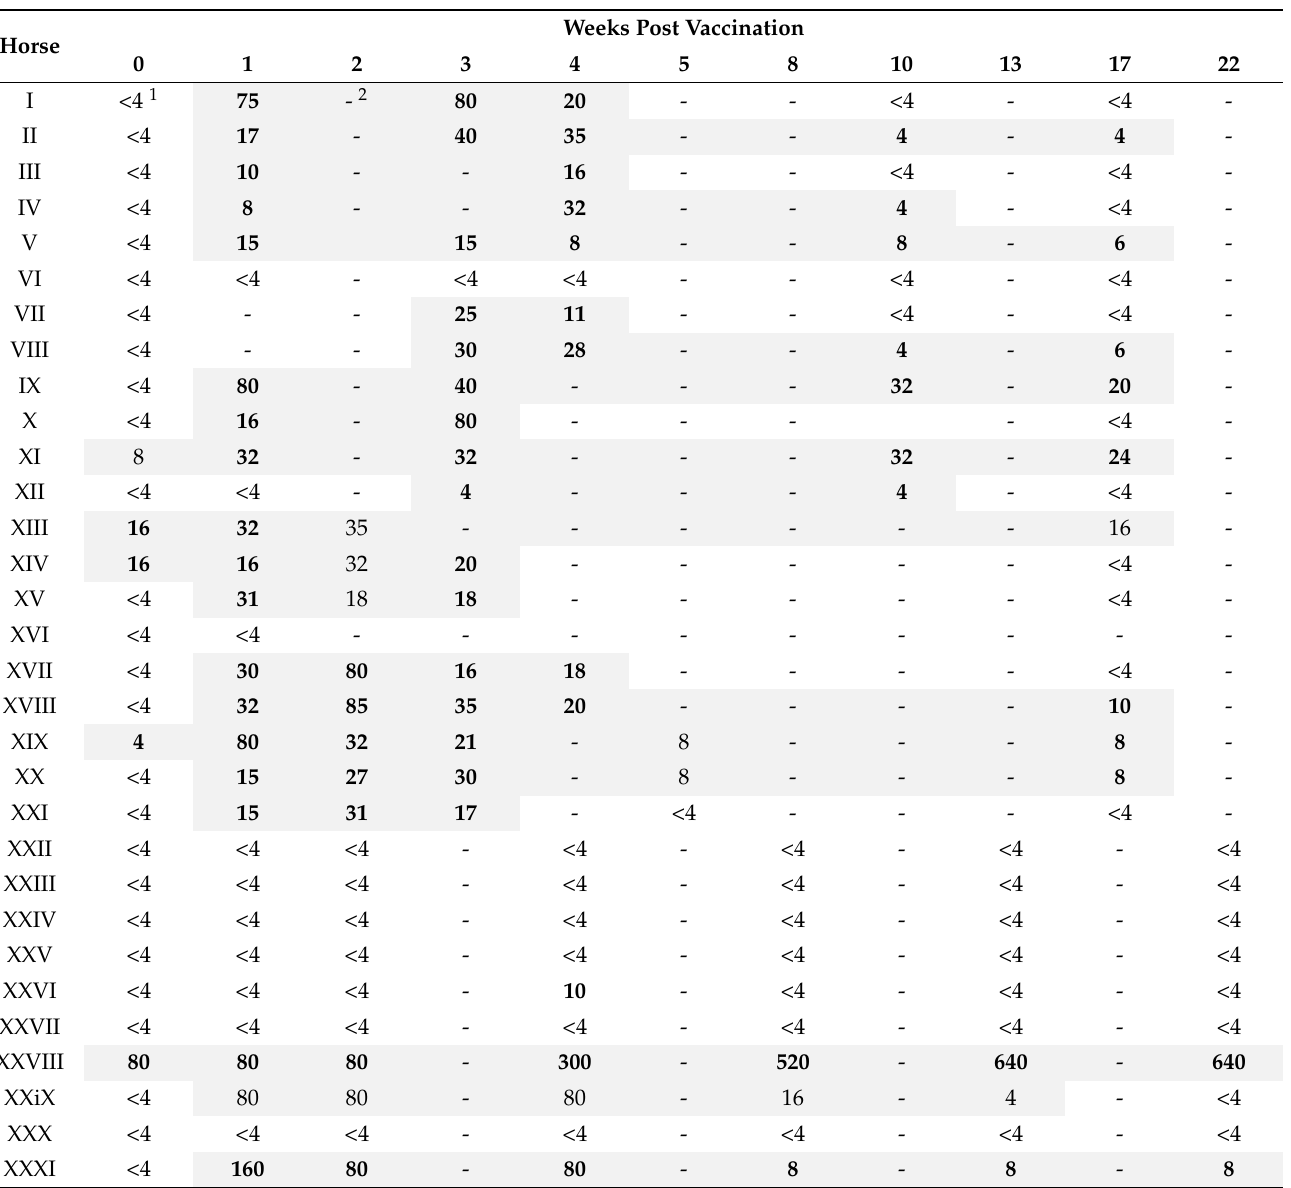
Table 3. Neutralizing antibody titers after vaccination with BoDV-1 live vaccine “Dessau” in horses already vaccinated in the years